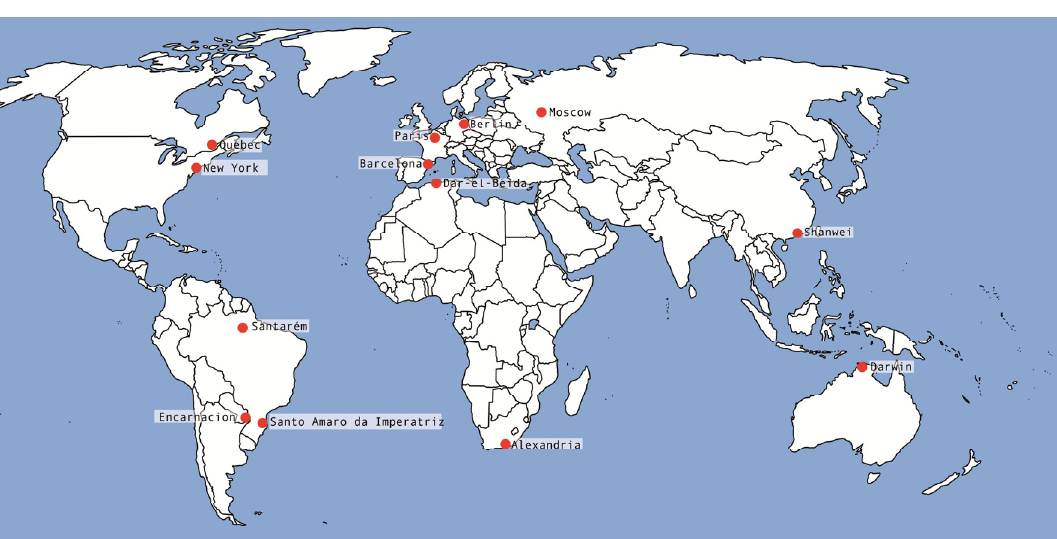
Figure 1. Location of selected